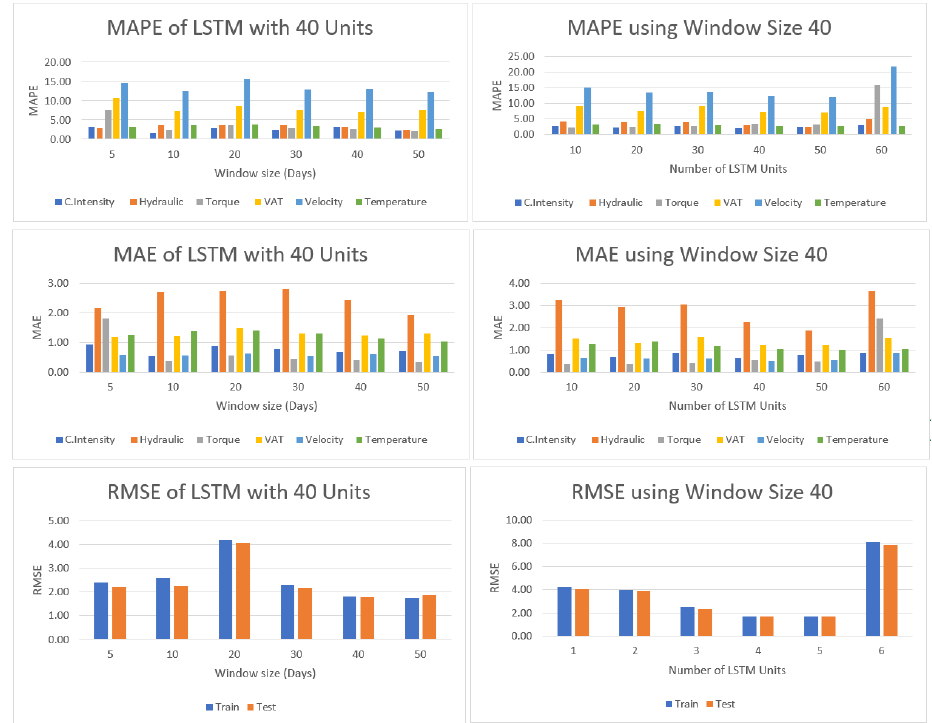
Figure 7. Results obtained with a different number of LSTM cells in the hidden layer, as well as different sliding window sizes, to predict values 30 days in advance with downsampling to one sample per